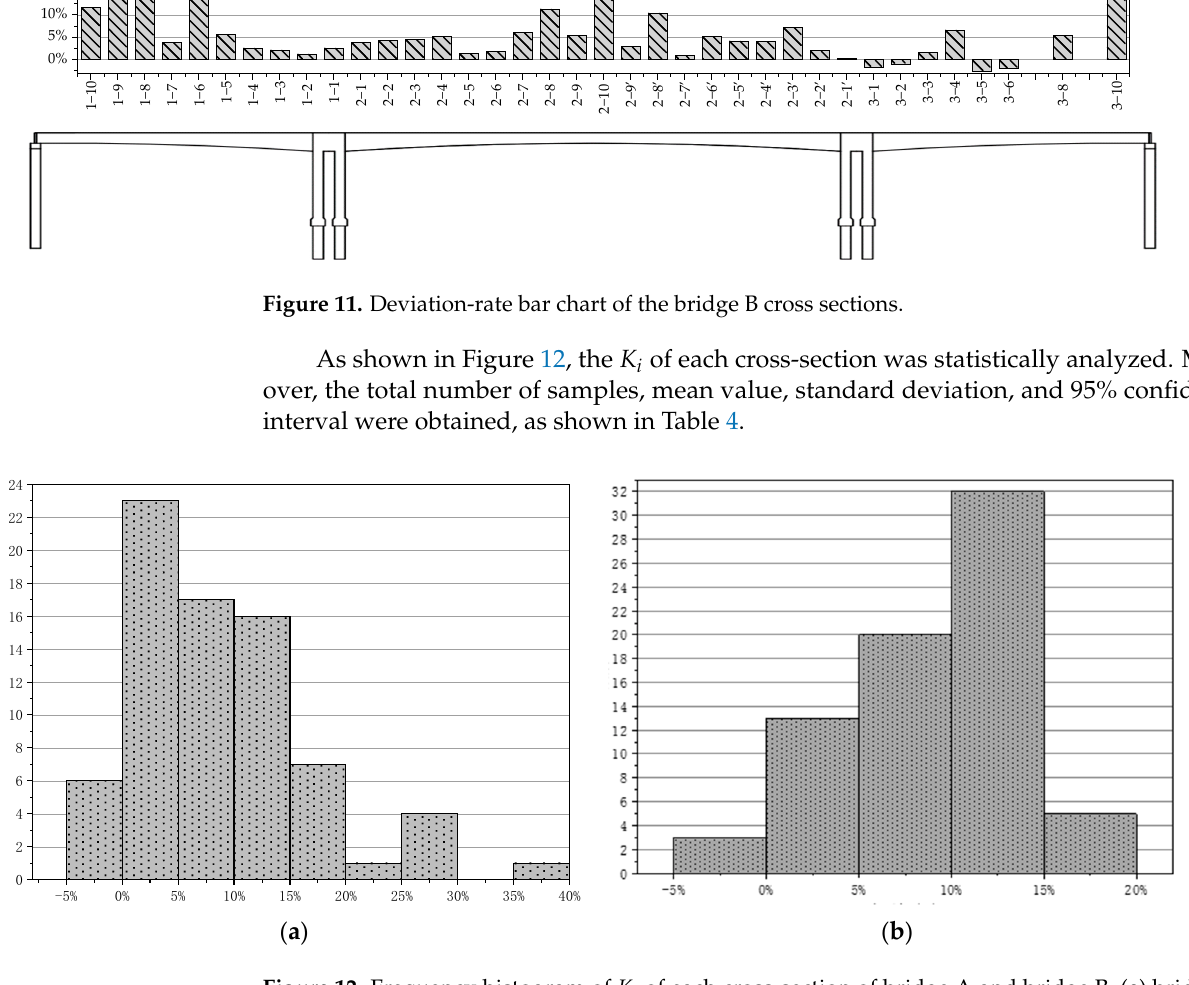
Figure 12. Frequency histogram of K i of each cross-section of bridge A and bridge B, ( a ) bridge A, ( b ) bridge B. Table 4. Statistical analysis of K i of bridge A and bridge